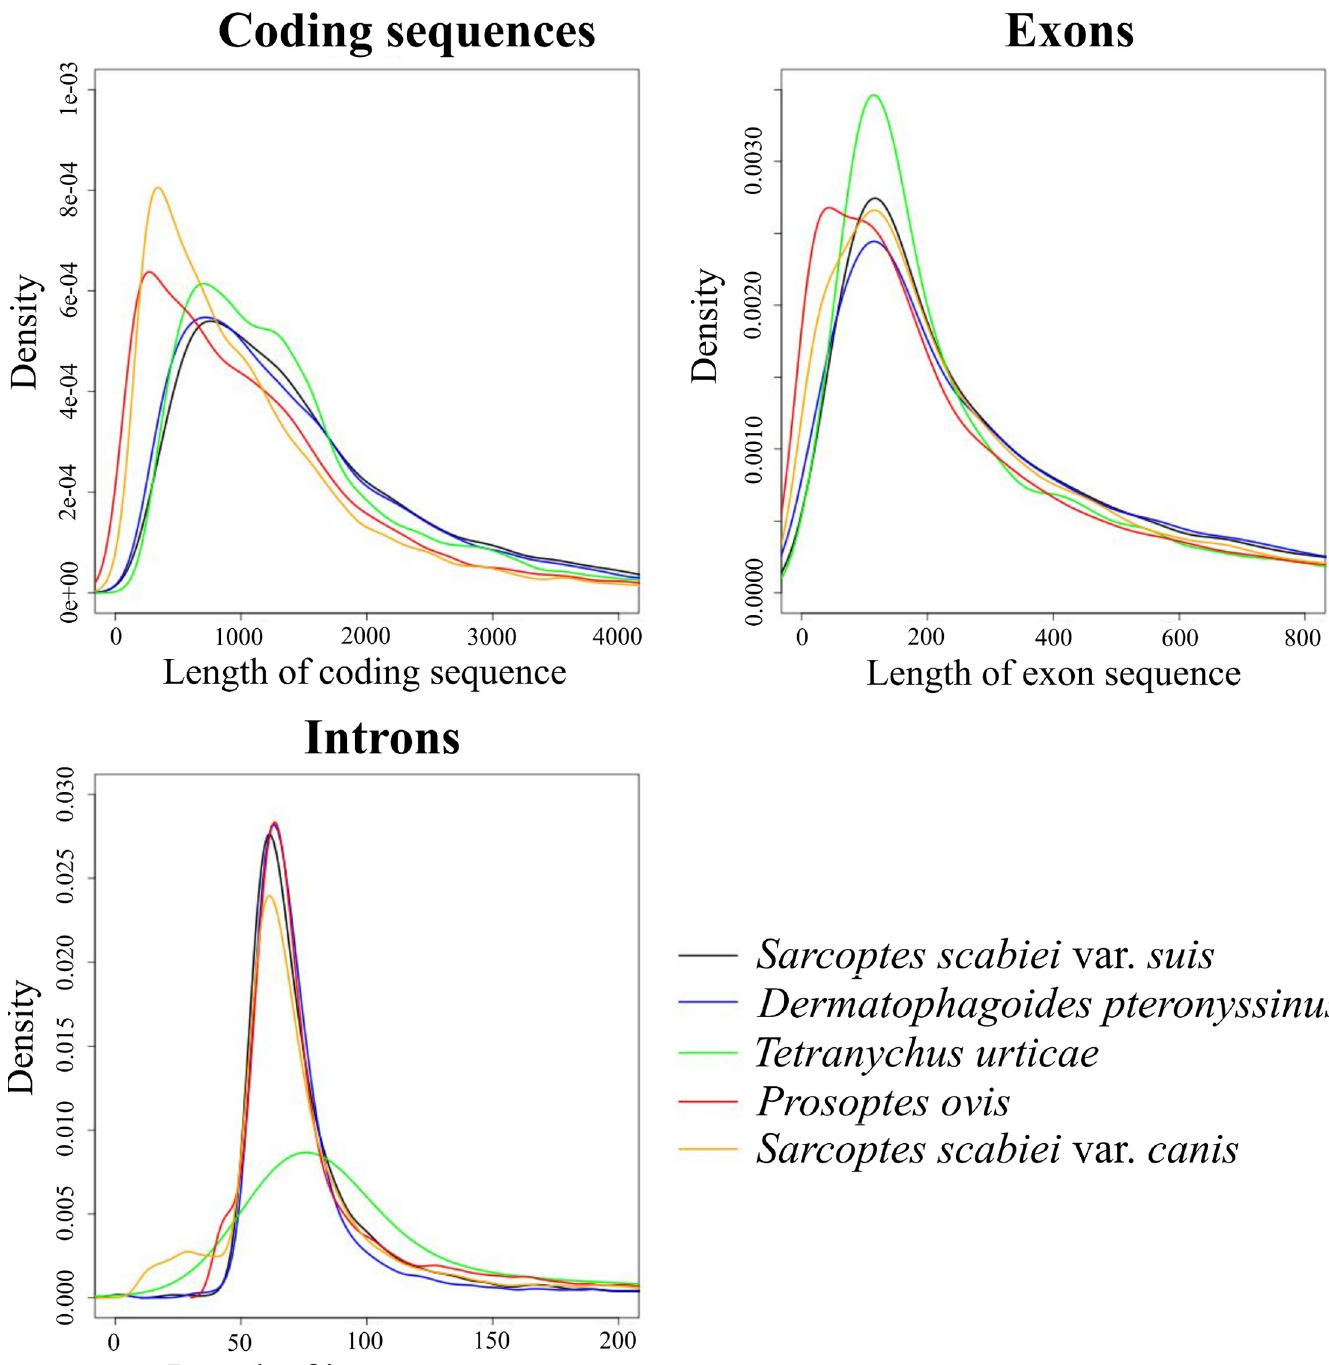
Fig 1. Characteristics of coding sequences, exons and introns. Density diagrams–showing the distribution of data–were used to compare coding sequences, exons and introns for the gene models of the mite species Sarcoptes scabiei var. suis (black), Dermatophagoides pteronyssinus (blue), Psoroptes ovis (red), Tetranychus urticae (green) and Sarcoptes scabiei var. canis (yellow). The NCBI accession identifiers for the genomes of the taxa included here are: WVUK01000000, GCF_001901225.1, GCA_002943765.1, GCF_000239435.1 and GCA_000828355.1, respectively.